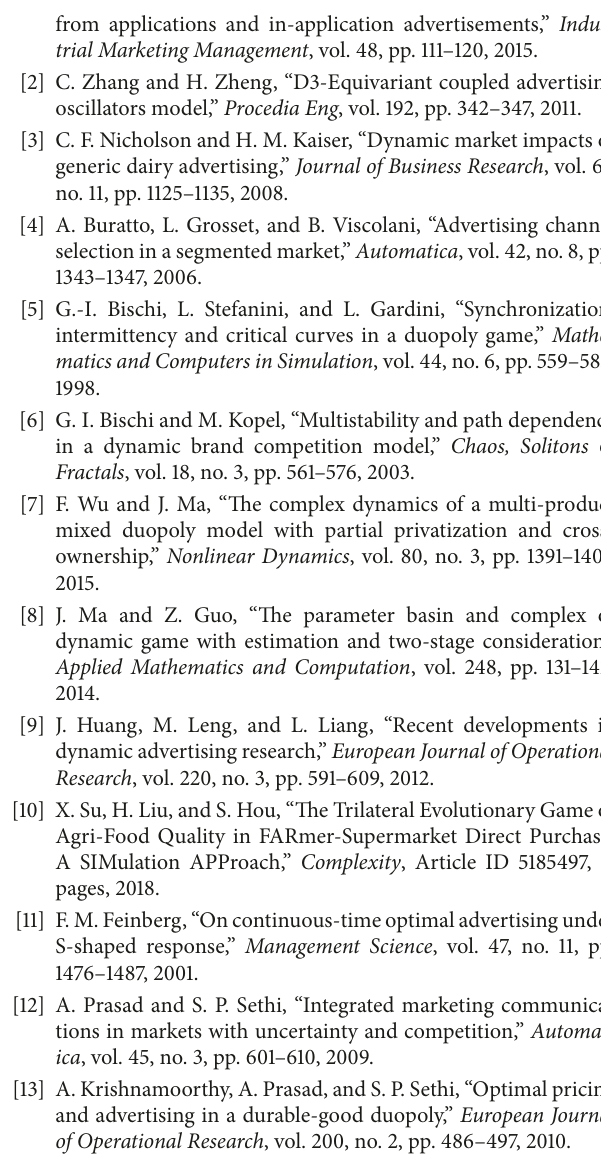
the profit 𝑃𝑆 (40) for 𝑝 ∈ (0.4, 1) and 𝑏 ∈ (2, 5.7) . These numerical results are in agreement with Proposition